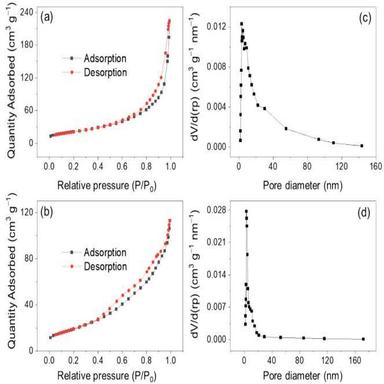
N2 adsorption-desorption isotherms of (a) ZnCo2O4 NSs and (b) ZnCo2O4 NWs, and pore size distribution of (c) ZnCo2O4 NSs and (d) ZnCo2O4 NWs.